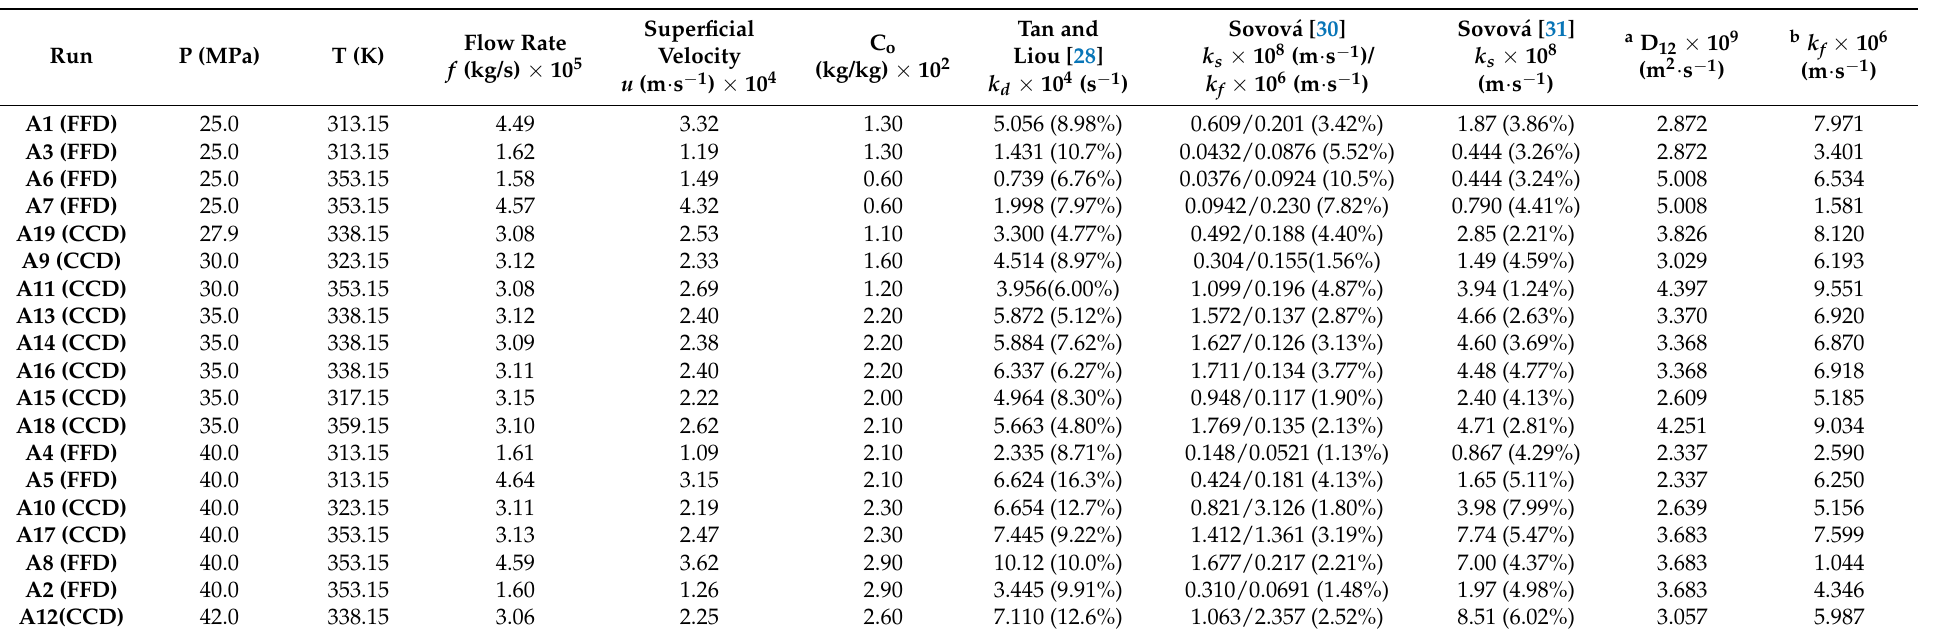
Table 6. Experimental conditions, principal parameters, and mass transfer coefficients for the rice bran oil extraction by SC-CO 2